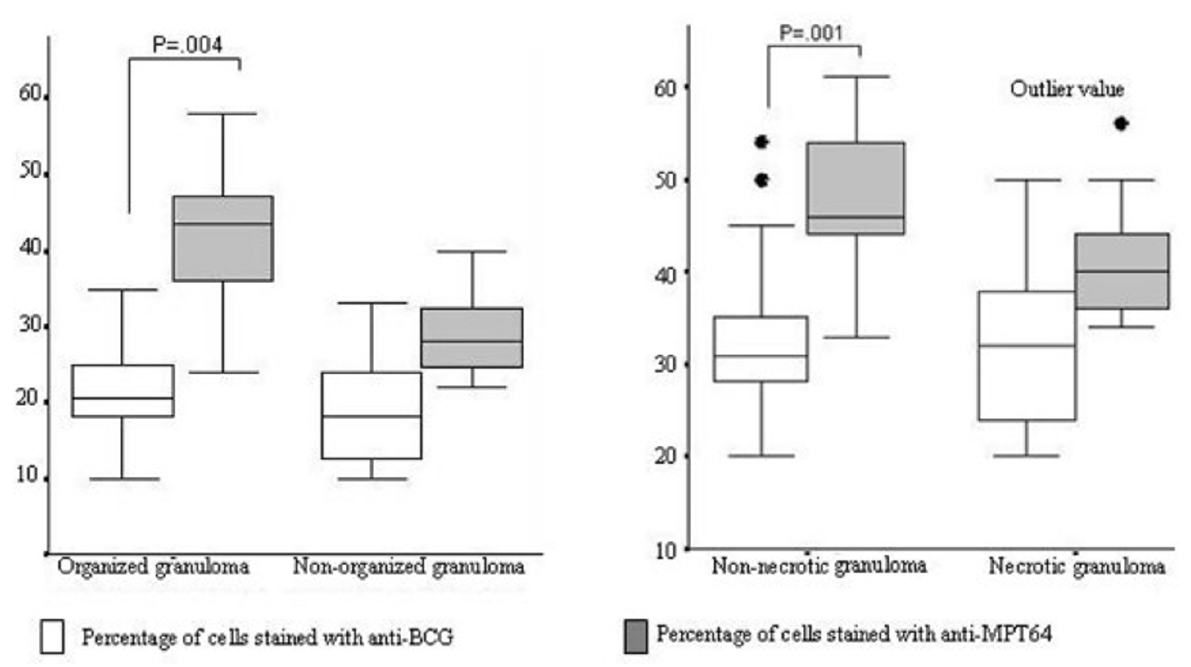
Figure 1 A: Percentage of stained cells by two antibodies in relation to organization of granuloma. B: Percentage of stained cells by two antibodies in relation to necrosis in